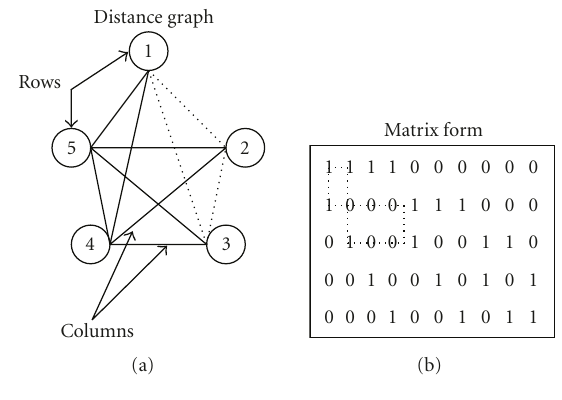
Figure 1: Graph and matrix LDPC code